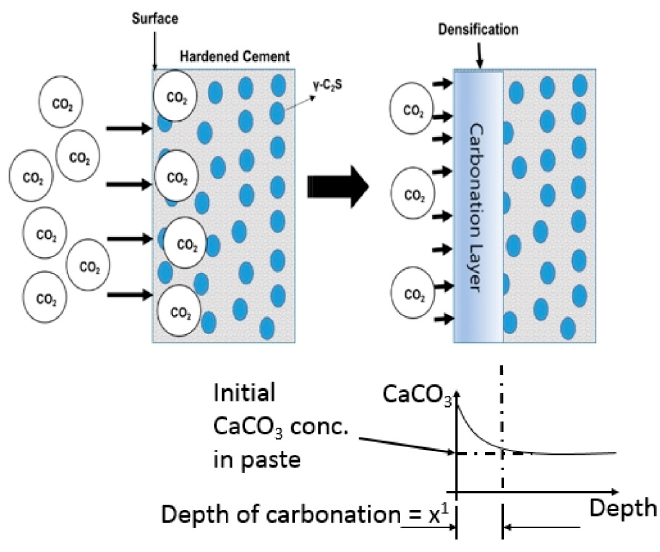
Figure 7. Densification on the surface of the pastes due to carbonation. Figure 7. Densi fi cation on the surface of the pastes due to carbonation. Figure 7. Densi fi cation on the surface of the pastes due to carbonation.